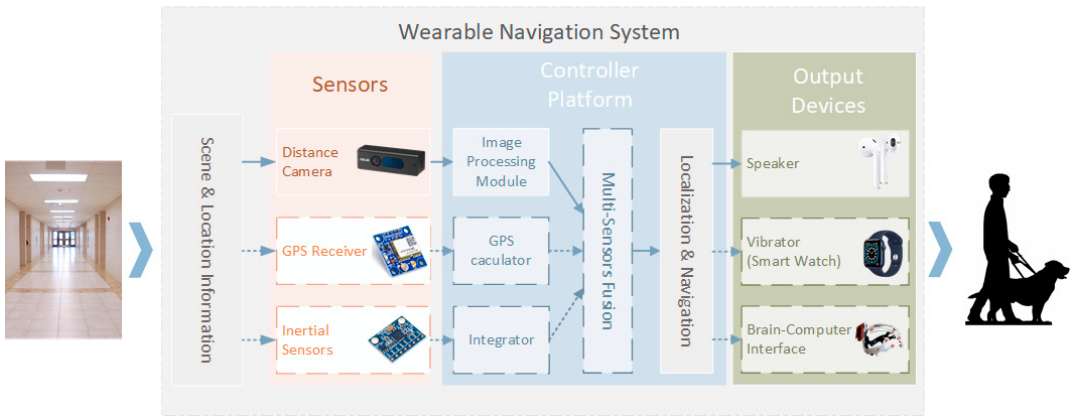
Figure 1. A usual wearable navigation system structure. The devices and methods we apply are shown by the solid lines.